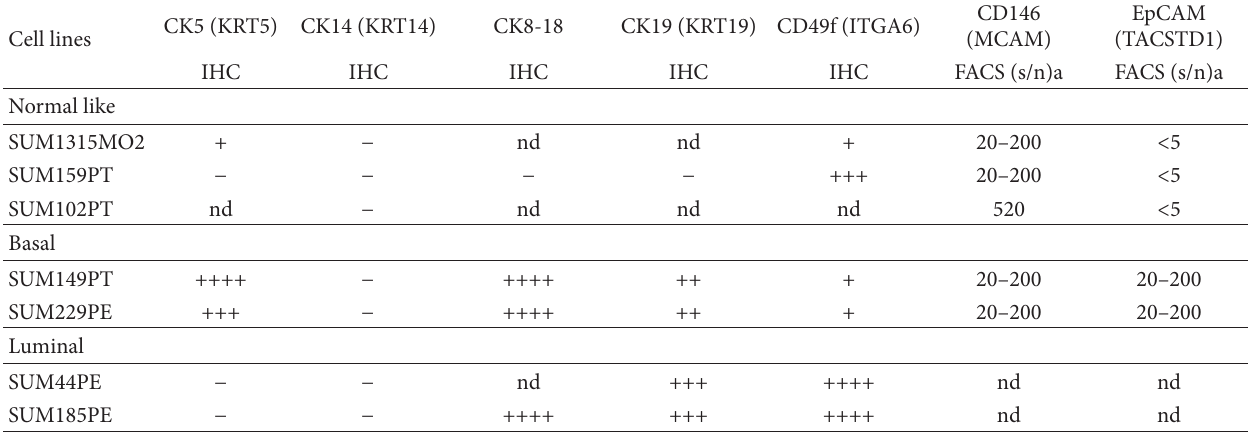
T 6: Protein expression of cytokeratins and CD49f/EPCAM in SUM